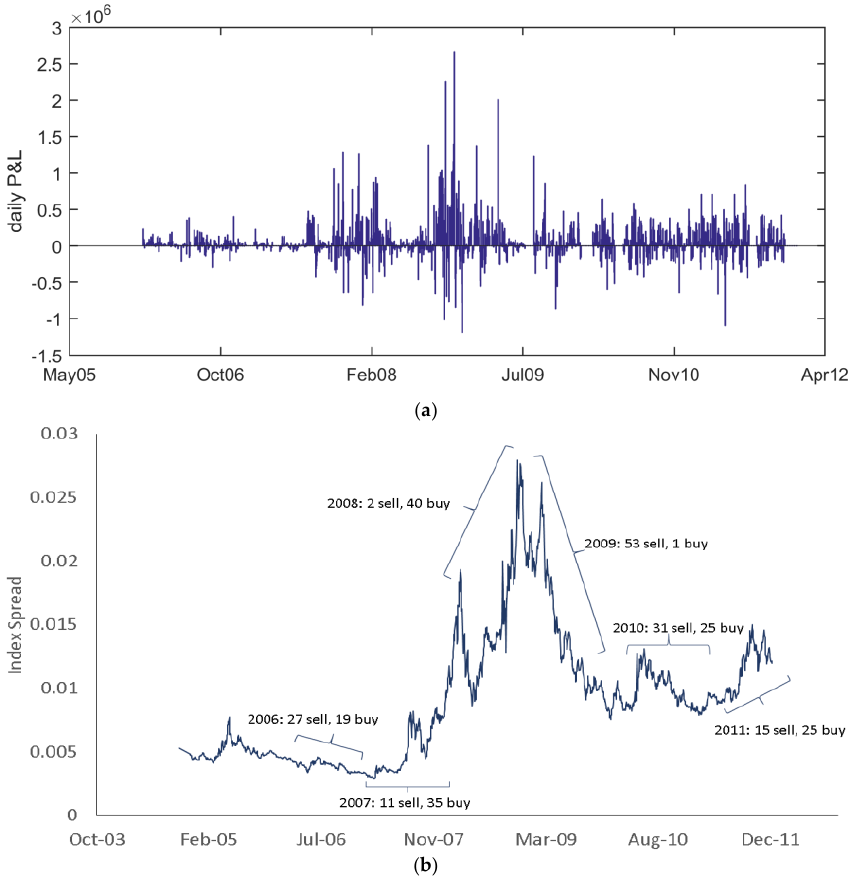
Figure 11. Back testing: 2006 to 2011 for ( a ) daily P&L and ( b ) long versus short positions plotted against the on-the-run North American investment grade credit index, CDX.NA.IG.